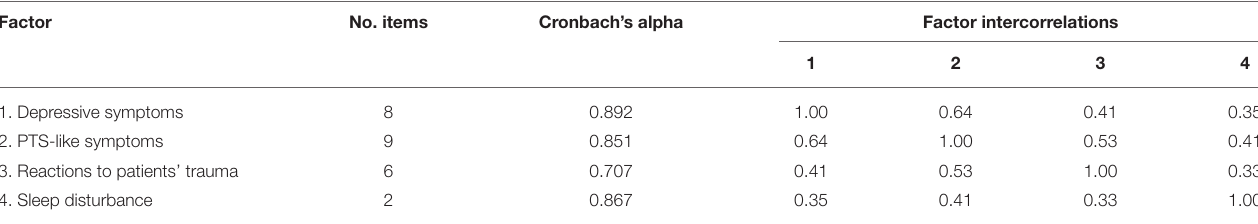
TABLE 4 | Descriptive statistics and intercorrelations for factors extracted from final exploratory principal axis factoring solution.